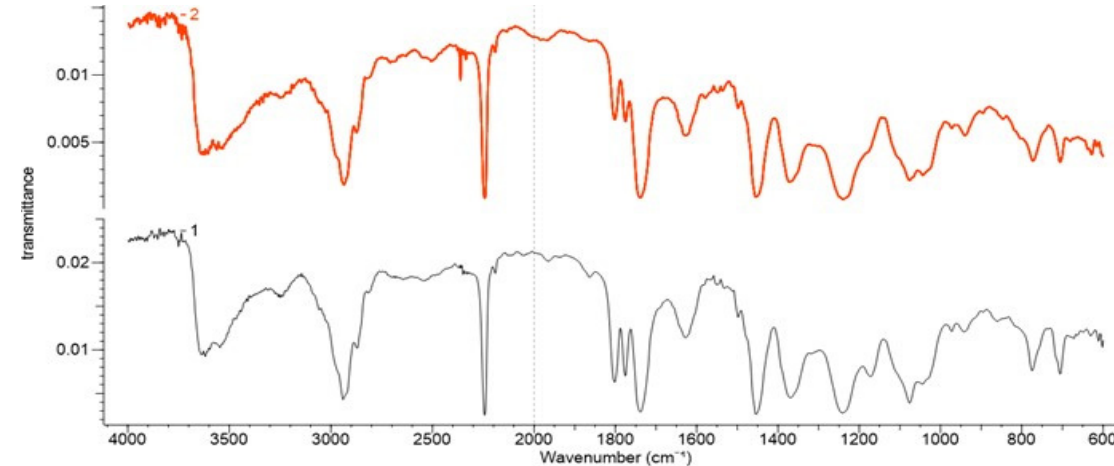
Figure 2. FTIR spectra of Melana: ( 1 ) pristine/untreated and ( 2 ) after functionalization.